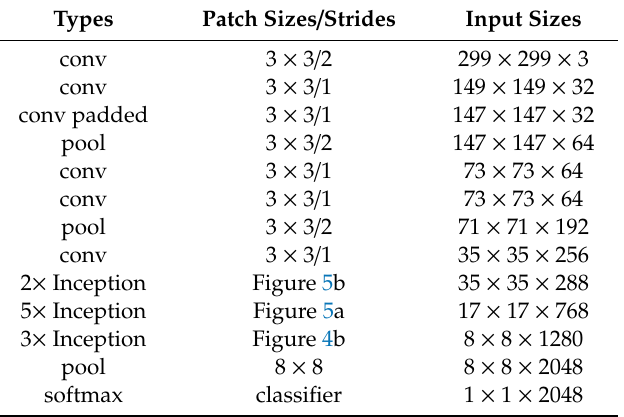
Table 1. The outline of our proposed network architecture.